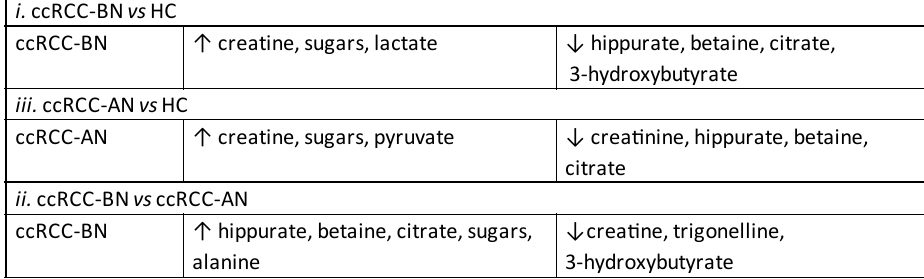
Figure 2. Results of OPLS-DA applied on the three groups of urine samples, compared two-by-two. On the left there are the score plots, reporting the predictive component on X-axis (t1) and the first orthogonal component on Y-axis (to1); on the right there are the loading plots, reporting the variables (buckets of 0.04 ppm) on X-axis and the corresponding loading vector values of the predictive component (pq1 normalized to unit length) on Y-axis.